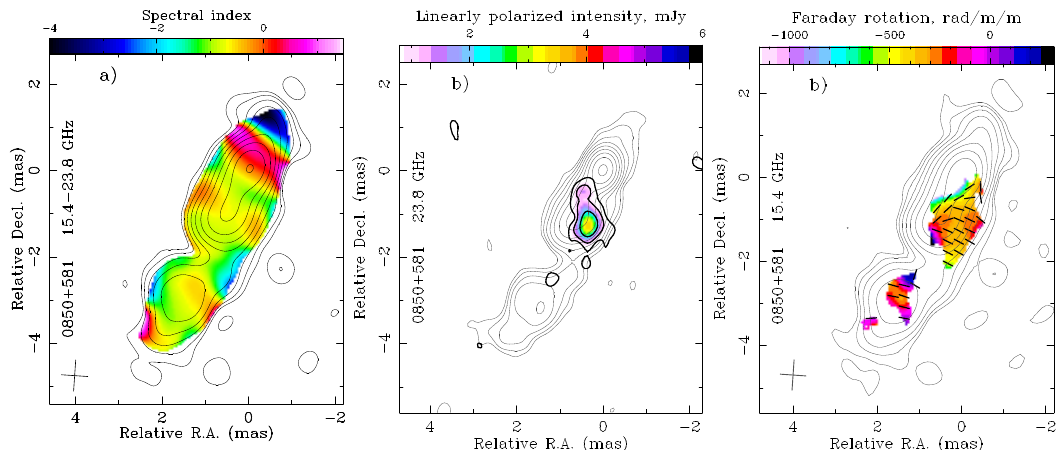
Figure 2. ( a ) 0850 + 581 15.4–23.8 GHz spectral index distribution (color) overlaid on Stokes I levels (solid grey lines). Contours are drawn at ( − 1,1,2,4...) × 0.6 mJy. Spectral index α is defined as S ∝ ν α , where S is the flux density observed at frequency ν . ( b ) Contours of linearly polarized intensity (black solid lines) overlayed on Stokes I levels (grey solid lines) at 23.8 GHz and drawn at ( − 1,1,2,4...) × 0.46 mJy. ( c ) Faraday rotation measure, determined in the range 8.1–23.8 GHz, together with Stokes I levels (grey solid lines) and Faraday-corrected EVPA (black solid sticks) at 15.4 GHz, drawn at ( − 1,1,2,4...) × 0.6 mJy.